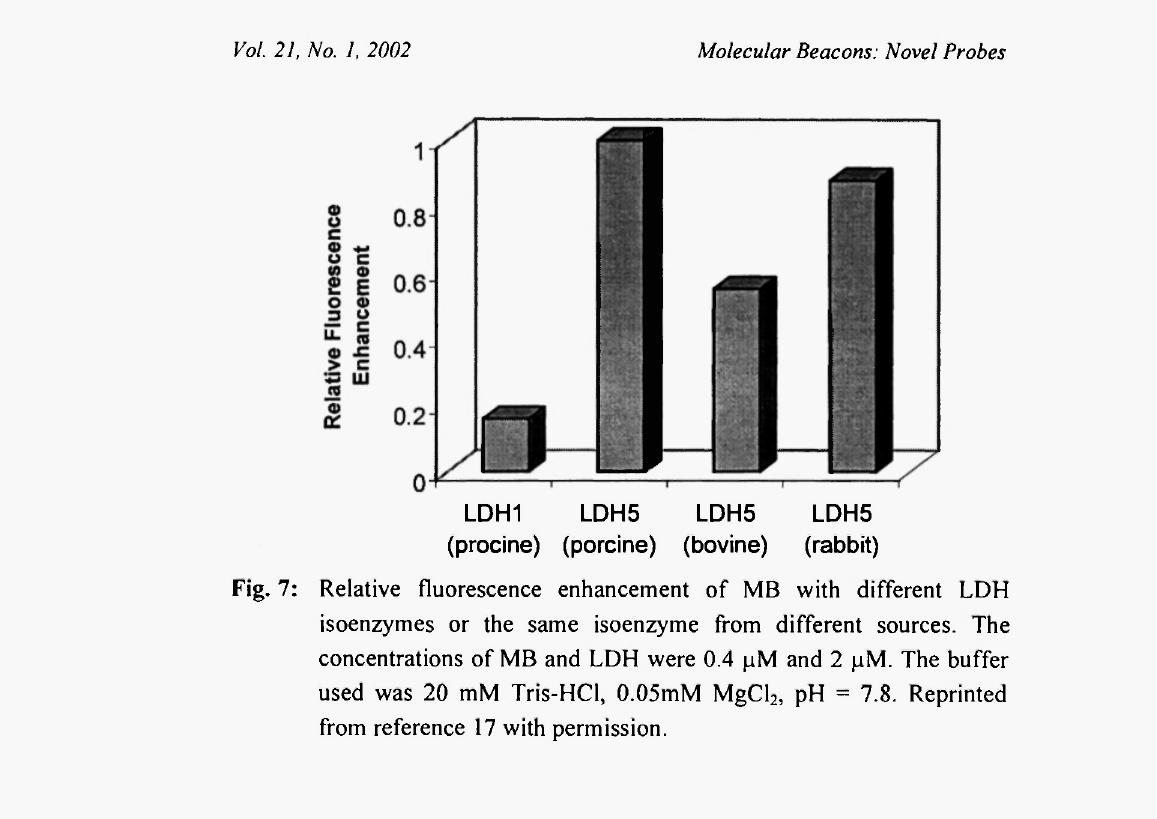
Fig. 7: Relative fluorescence enhancement of MB with different LDH isoenzymes or the same isoenzyme from different sources. The concentrations of MB and LDH were 0.4 μΜ and 2 μΜ. The buffer used was 20 mM Tris-HCl, 0.05mM MgCl 2 , pH = 7.8. Reprinted from reference 17 with